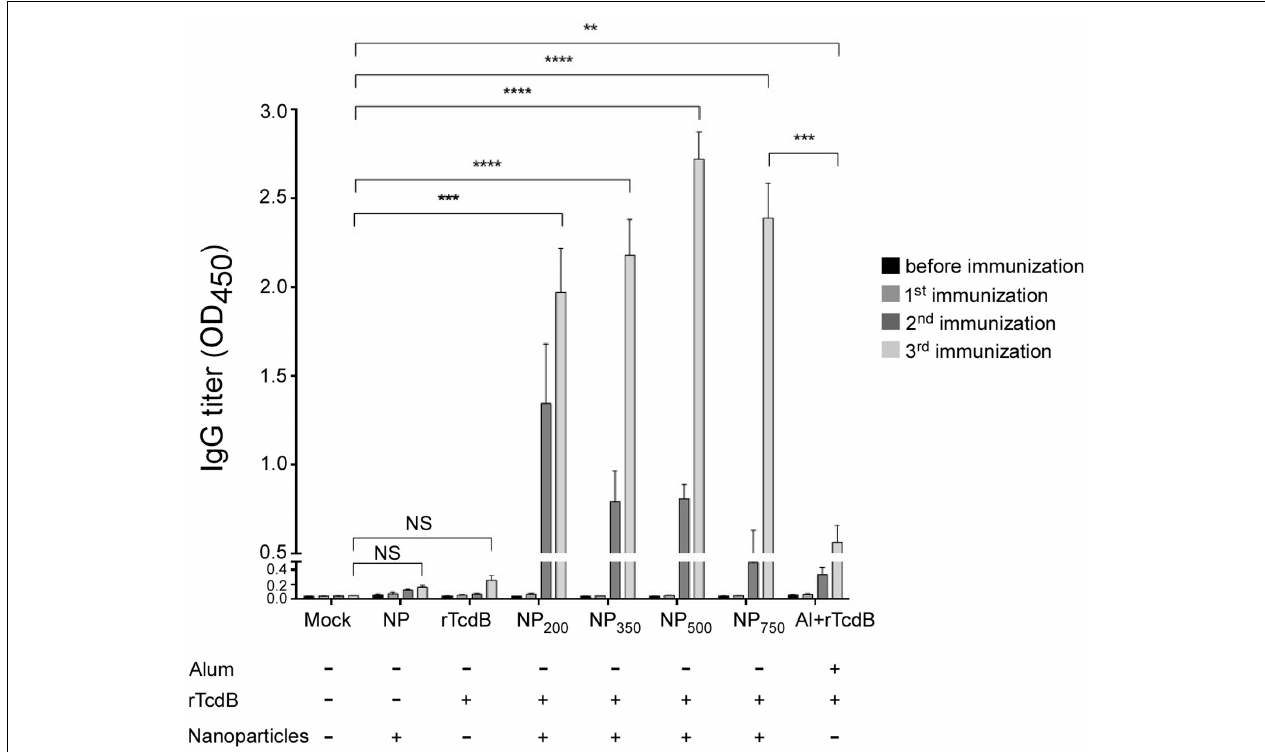
FIGURE 2 | Induction of antigen-specific IgG in nanoparticle vaccinated mice. ELISA was performed in triplicate using coated peptide pool. Serum IgGs (1:20,000 dilution) in differentially immunized mice were compared. Mock: PBS injection only; NP: empty nanoparticle infection; rTcdB: injection with 20 µ g purified rTcdB in PBS. NP 200 , NP 350 , NP 500 , and NP 750 : injection with NP-rTcdBs with the corresponding size in nanometers; Al+rTcdB: injection with 20 µ g purified rTcdB mixed with Alum. All data are presented as mean ± standard deviations and statistical comparisons among groups were analyzed by Student’s t -test and ANOVA ( ∗∗ p ≤ 0.01, ∗∗∗ p ≤ 0.001, ∗∗∗∗ p ≤ 0.0001). NS, not significant. All data are representative of at least three independent